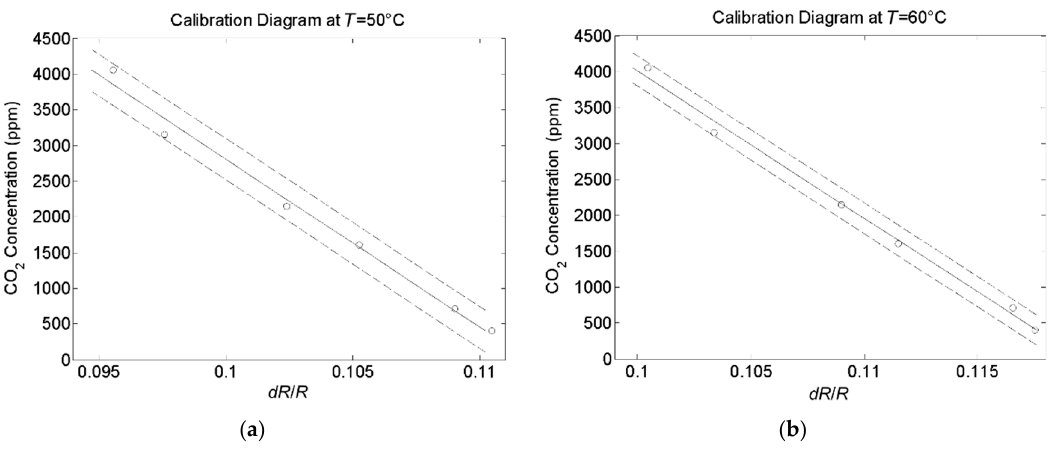
Figure 5. The calibration diagrams for two operating temperatures: ( a ) 50 °C and ( b ) 60 °C. The uncertainty bands are represented by the dotted lines.